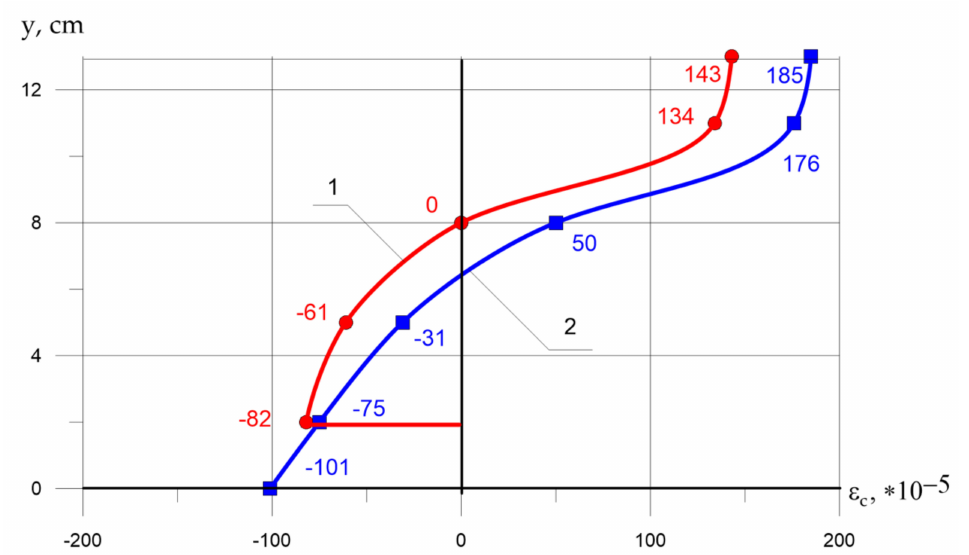
Figure 8. Dependence of longitudinal strains in the cross section in columns KK-0.6 (1) and KKF-0.6 (2) at a load of 90